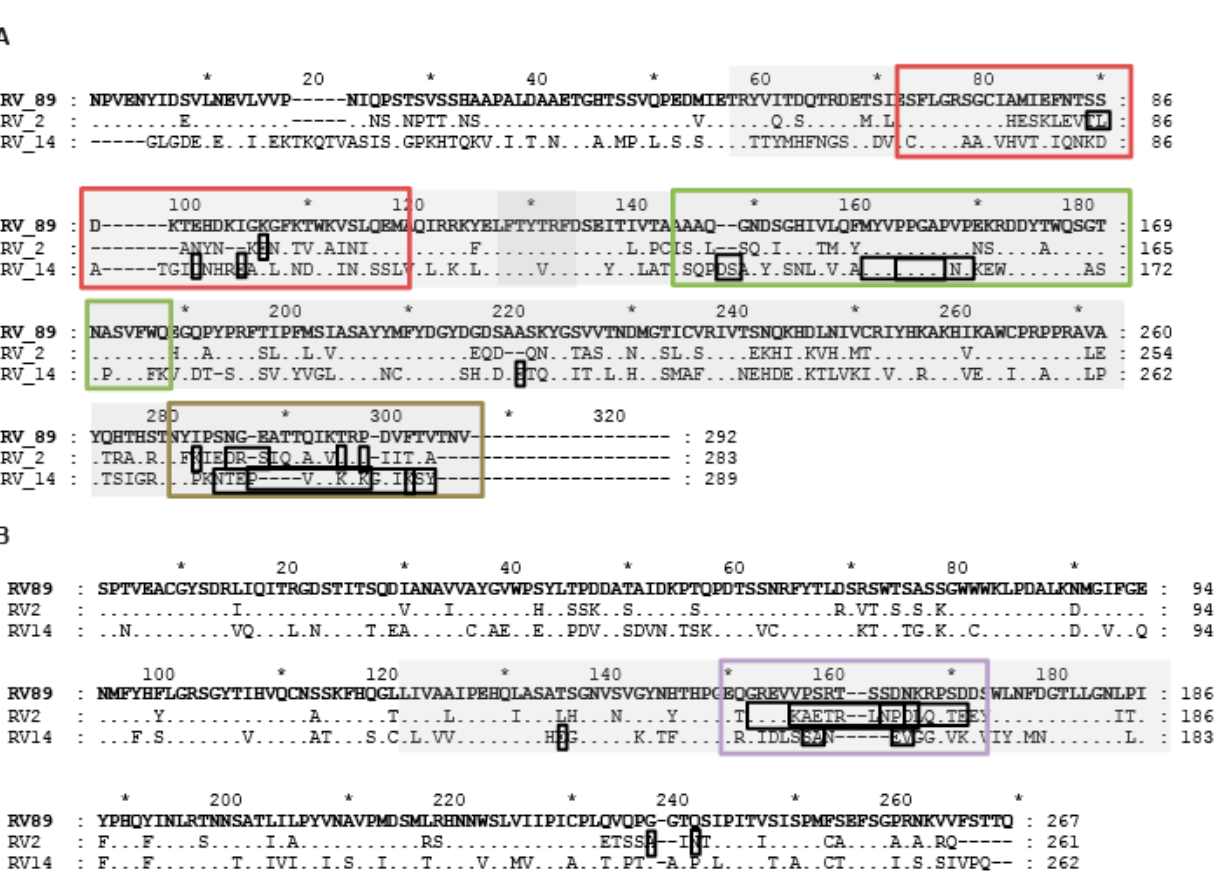
Figure 7. Sequence comparison of RV89 with two RV strains (RV2, RV14) for which epitopes involved in virus neutralization have been determined. Shown are amino acid sequence alignments of ( A ) VP1 and ( B ) VP2 capsid proteins of RV89 (major receptor group, RV-A) on top with RV2 (minor receptor group, RV-A) and RV14 (major receptor group, RV-B). The RV89-derived peptides identified as potential epitopes involved in virus neutralization in our study are boxed (red: 89VP1-p3; green: 89VP1-p5; brown: 89VP1-p9; purple: 89VP2-p11) and peptide-containing fragments included in 89RX1 and 89RX2 are highlighted in grey. Amino acids boxed in black were previously reported to be involved in virus neutralization (Table 1). Left margin indicates strain number; dots and dashes represent identical amino acids and gaps, respectively.